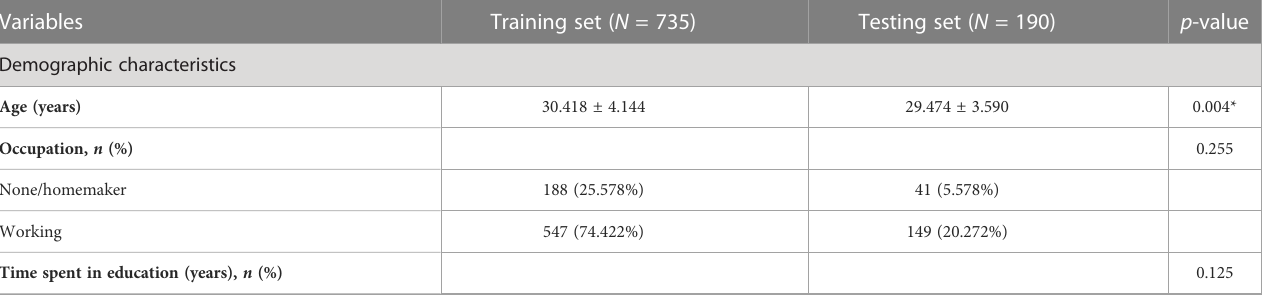
TABLE 2 Demographic characteristics, clinical features, and laboratory parameters of the training and testing sets.